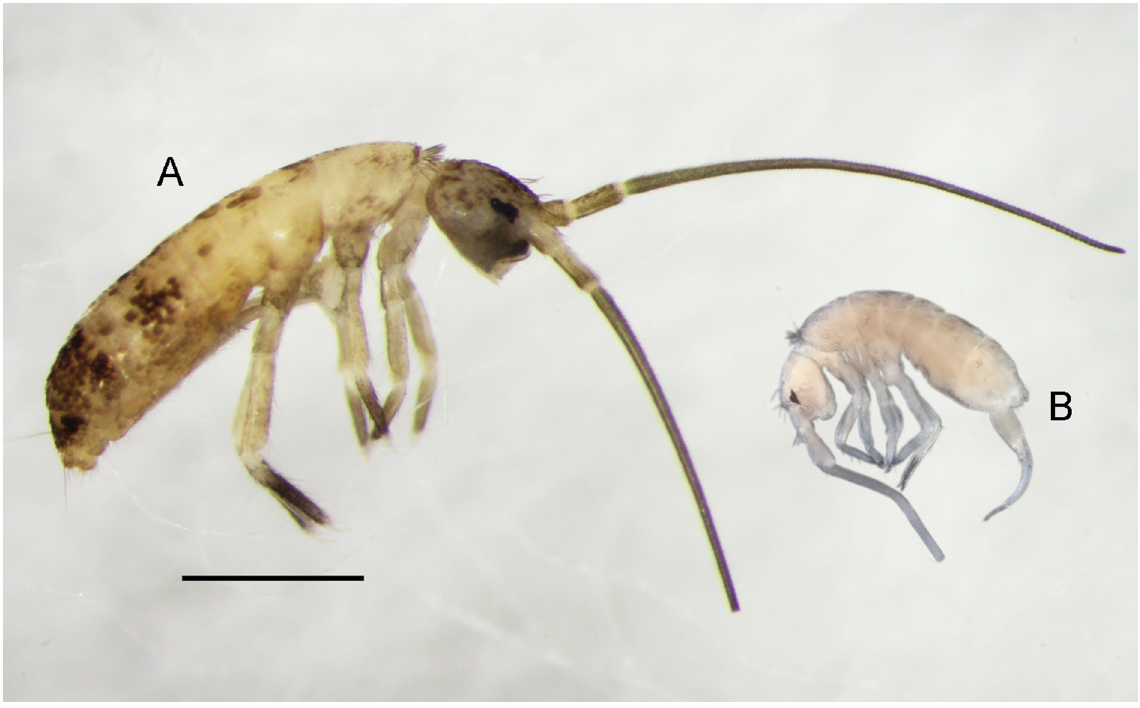
A . Tomocerus ocreatus (lateral view). B . Tomocerina annamitica sp. nov. (lateral view). Scale bar: 1